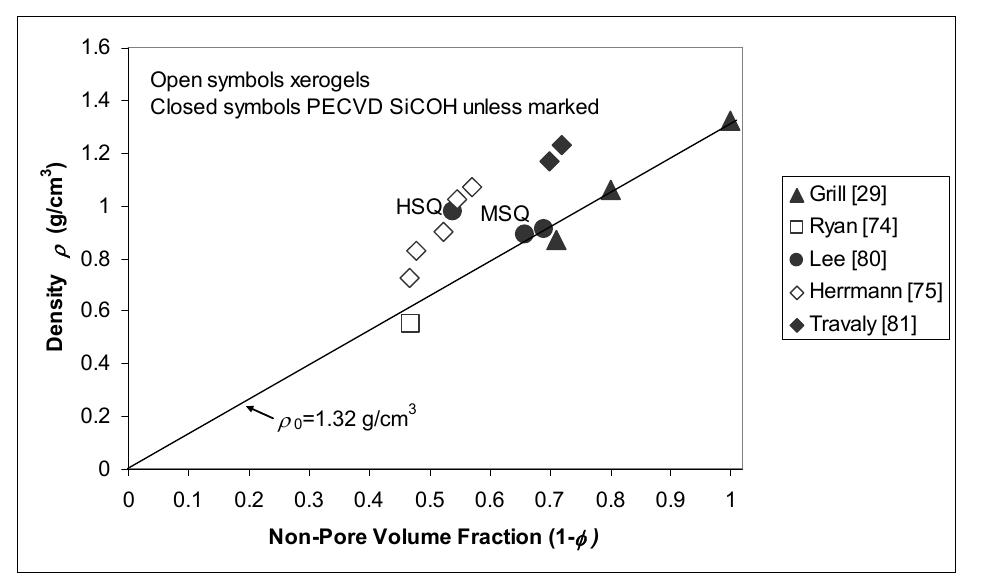
Figure 2. Density ρ plotted against non-pore volume fraction (1- φ ) for several PECVD and spin-on dielectric materials. The line represents the prediction of equation (1) assuming = 1.32 g/cm 3 , the density of the non-porous K = 2.8 film reported in ρ 0